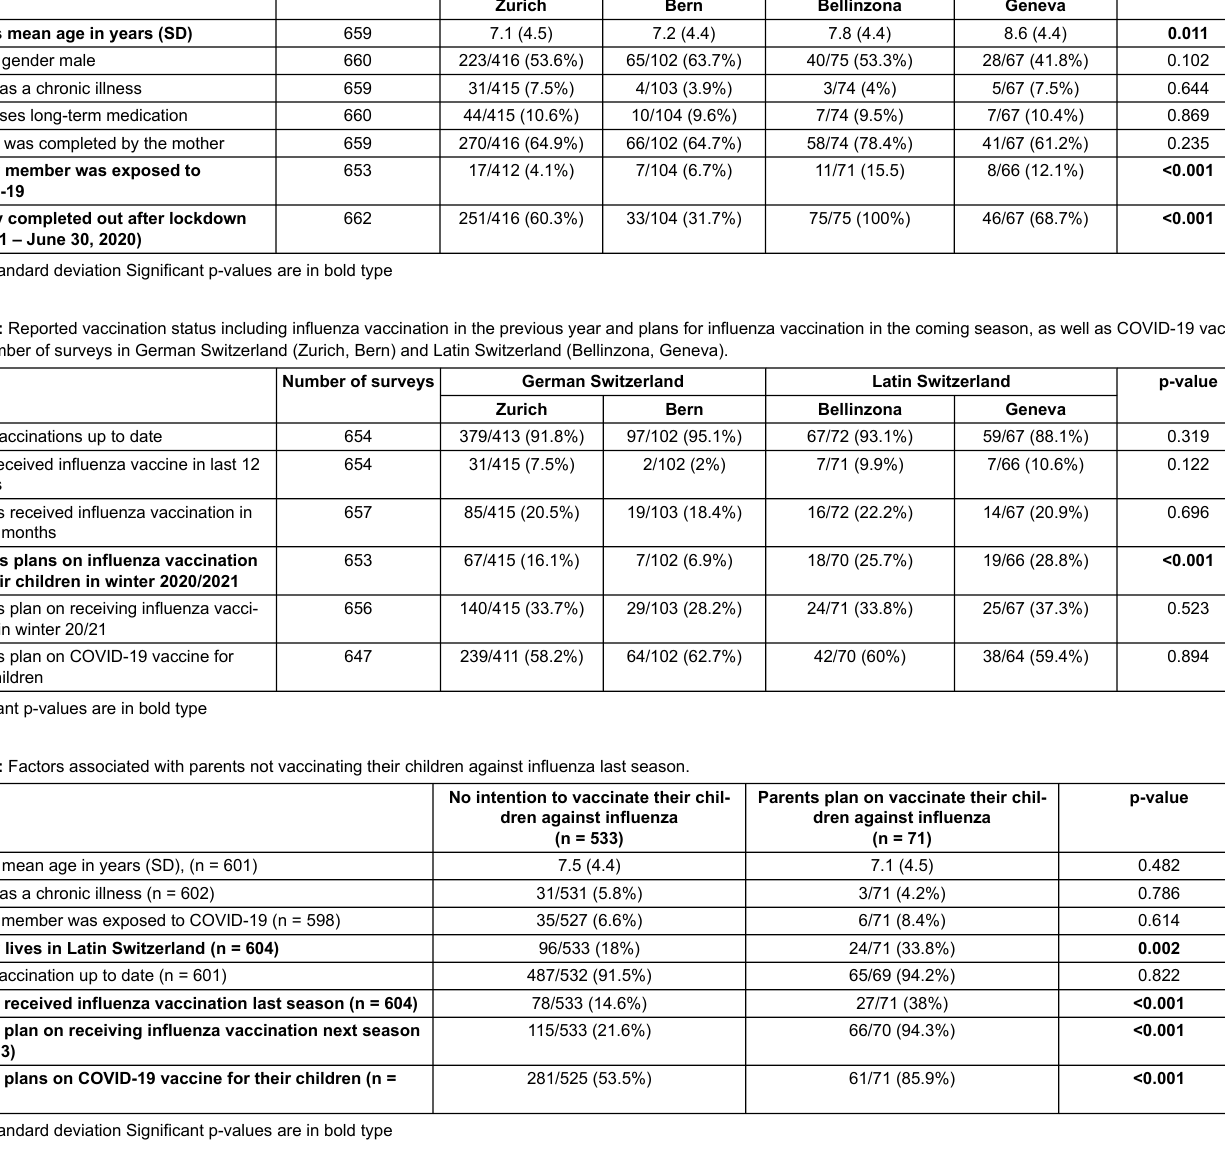
Table 1: Demographic information and number of surveys in German Switzerland (Zurich, Bern) and Latin Switzerland (Bellinzona, Geneva). Number of surveys